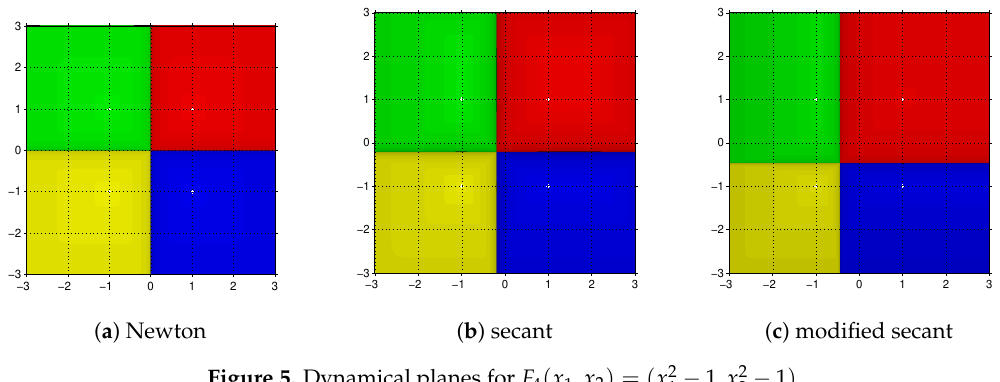
Figure 5. Dynamical planes for F 4 ( x 1 , x 2 ) = ( x 2